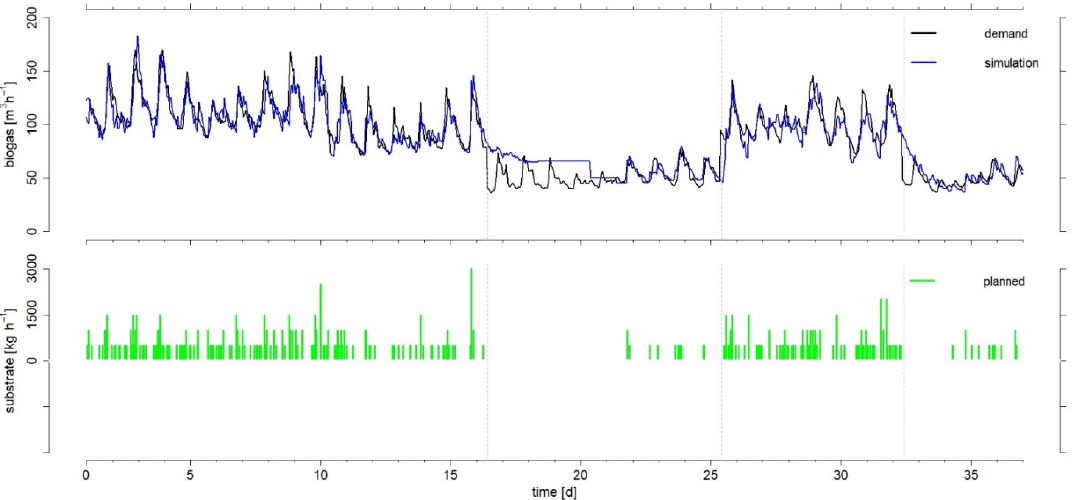
Figure 3. Biogas demand and simulated biogas production, as well as the associated daily feeding schedules in hourly resolution over the entire experimental period. The vertical grey lines identify start and end of the four experimental phases.